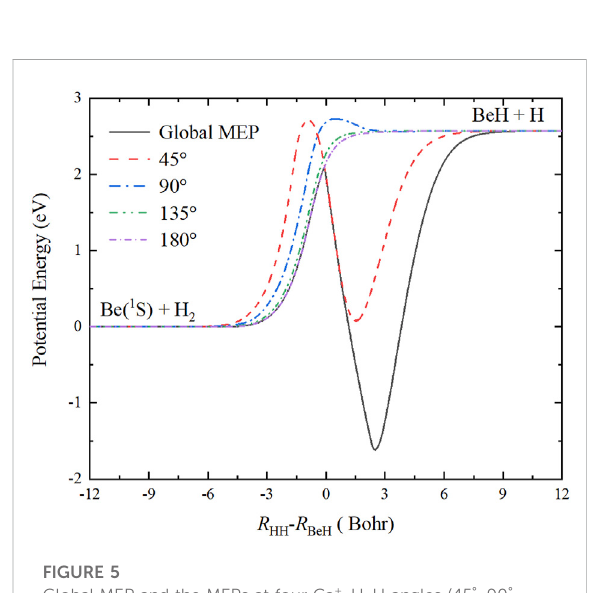
FIGURE 5 Global MEP and the MEPs at four Ca + -H-H angles (45 ° , 90 ° , 135 ° , and 180 ° ) of the Be( 1 S) + H 2 → BeH + H reaction obtained on the ground-state BeH 2